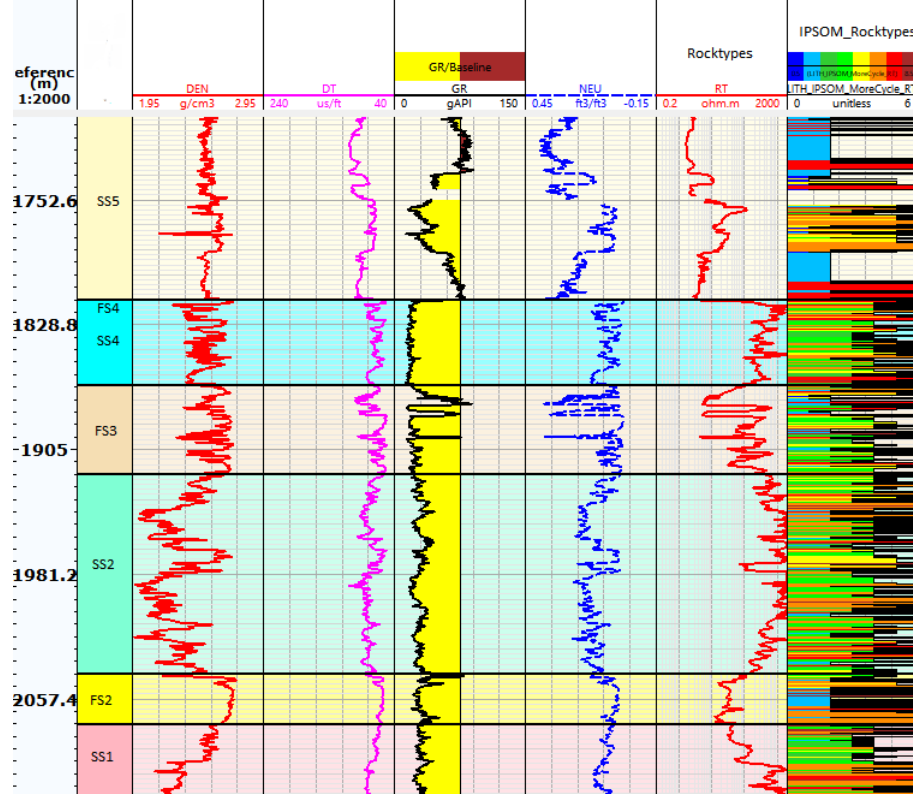
Figure 11. The above graphic shows in Column 8 the predicted rock types of E11-101.